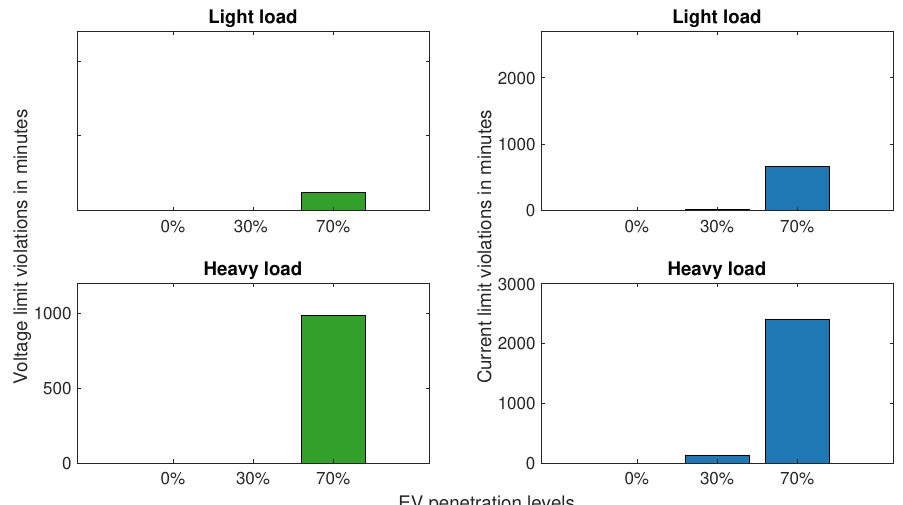
Figure 3. Comparison of voltage and current violations duration for different EV penetration rates between the heavy and light load